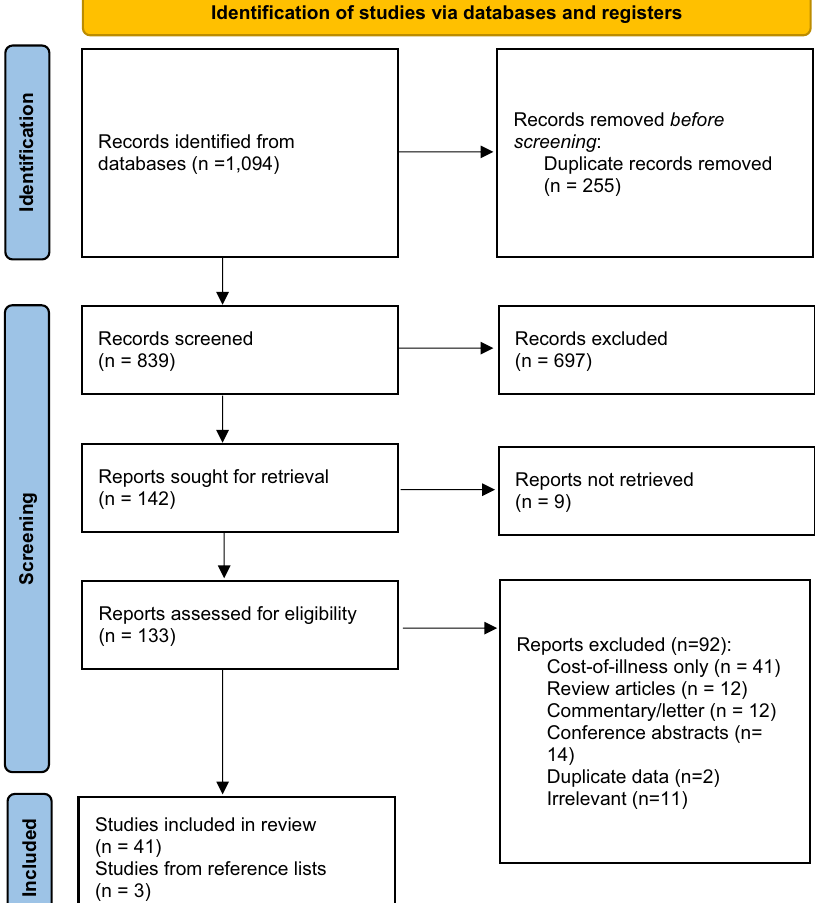
Fig. 1 PRISMA 2020 fl ow diagram for new systematic reviews which included searches of databases and registers only. Source: Page et al. 72